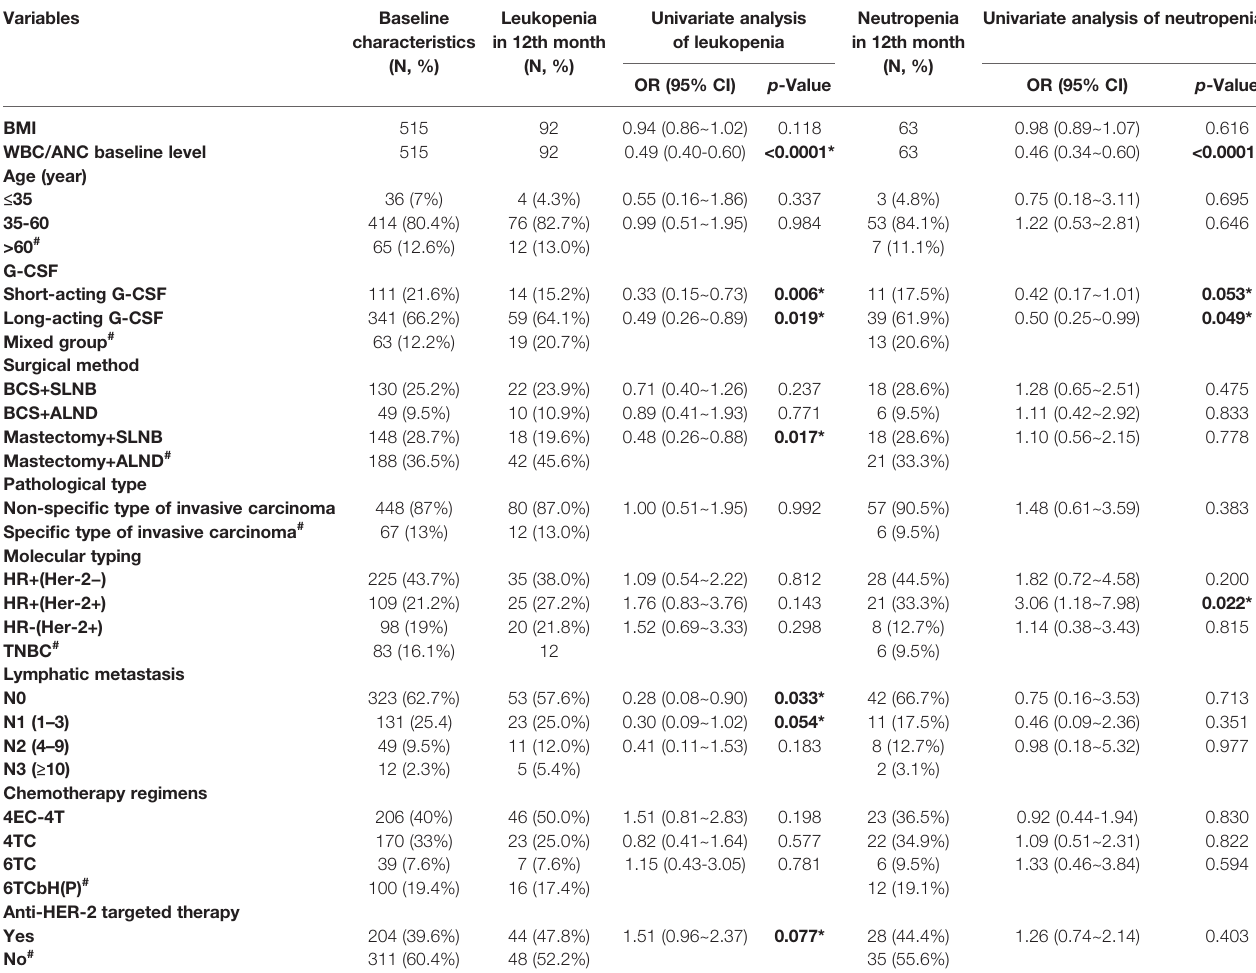
TABLE 1 | Univariate characteristics of patients in 12 months after the end of the last chemotherapy.